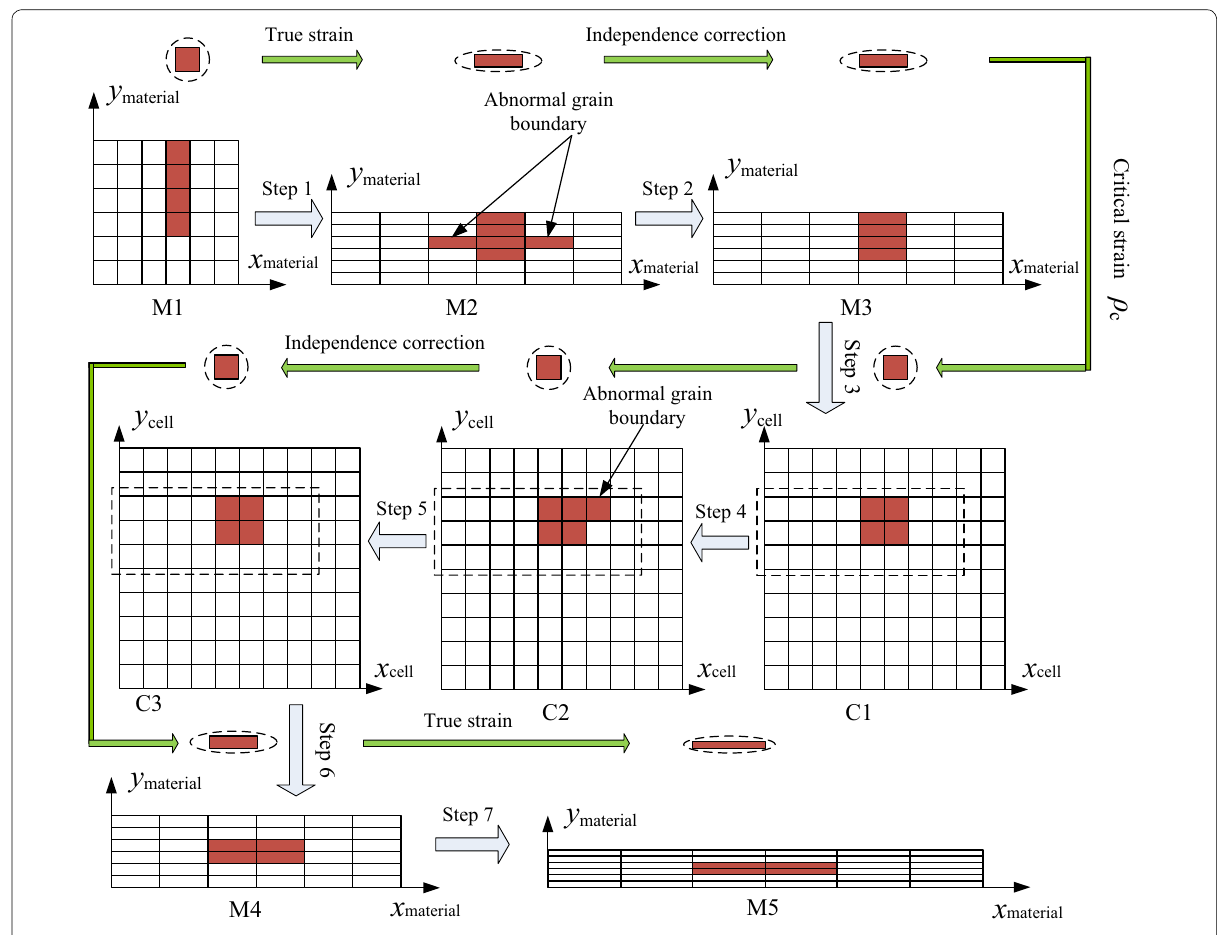
Figure 6 Grain boundary mapping during material‑cellular coordinate